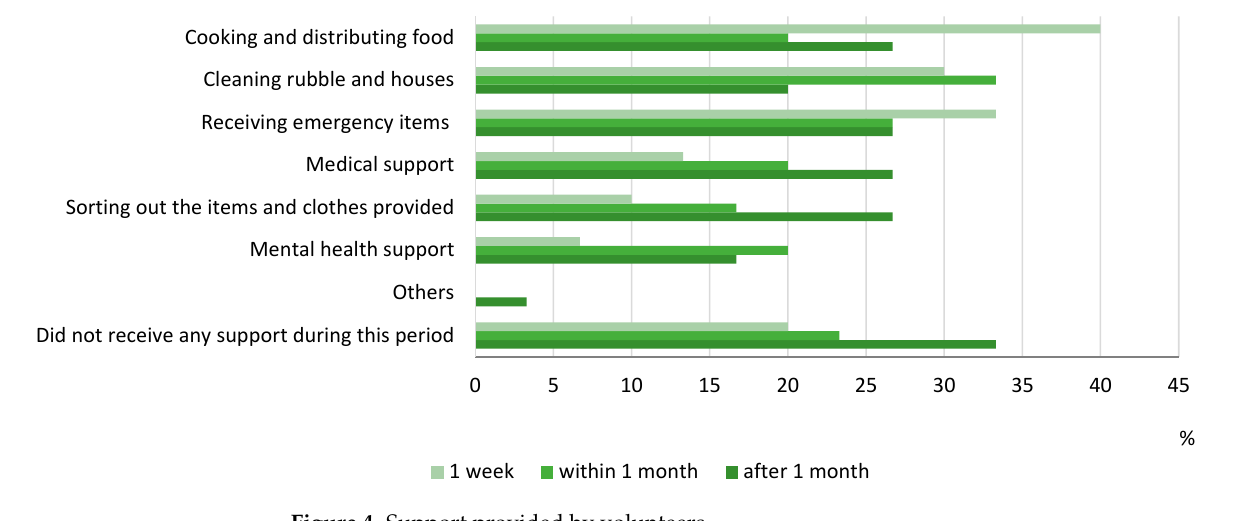
Figure 4. Support provided by volunteers.